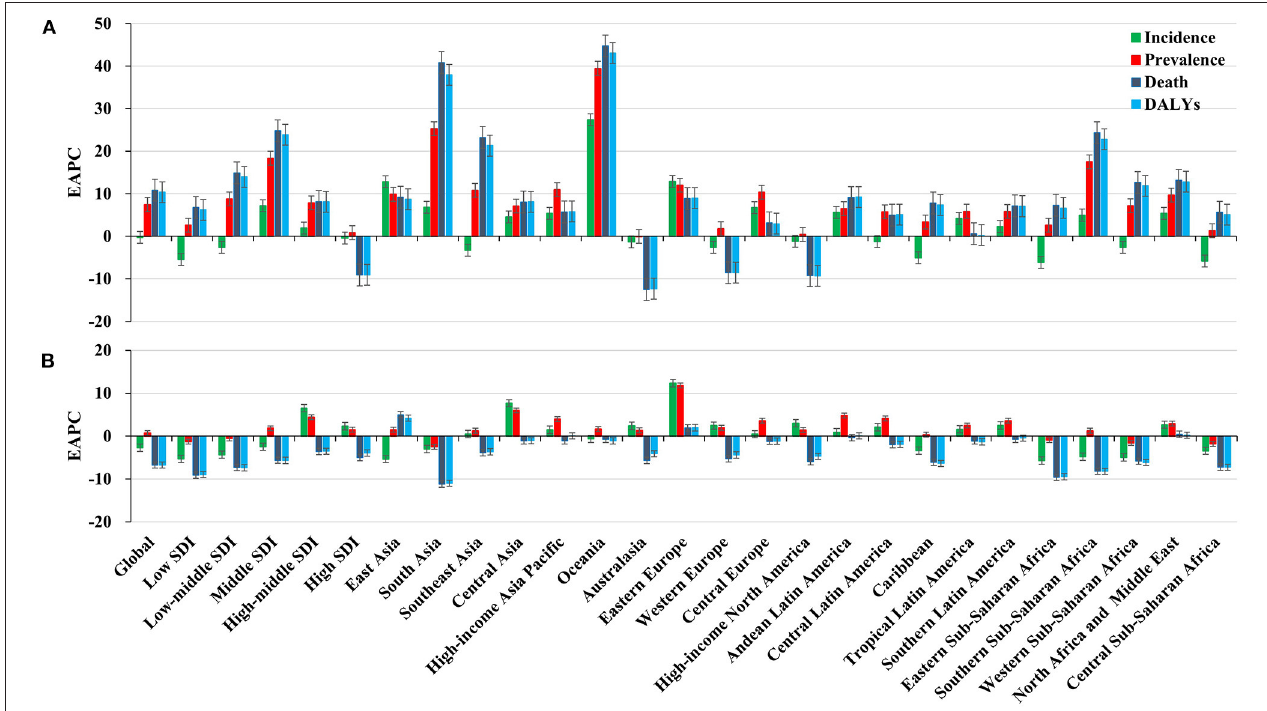
FIGURE 1 | Trends in HIV/AIDS disease burden, including incidence, prevalence, death, and DALYs worldwide across SDI areas and geographic regions. (A) Distribution of the EAPCs of HIV/AIDS from 1990 to 2004; (B) Distribution of the EAPCs of HIV/AIDS from 2005 to 2019. EAPC, estimated annual percentage